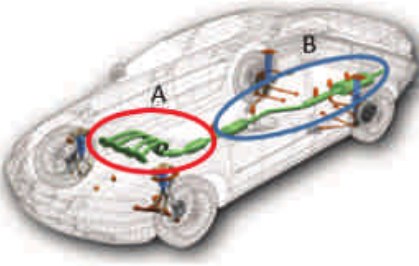
Fig. 1. Location of the exhaust system elements in a passenger car; A – "hot end", B – "cold end"